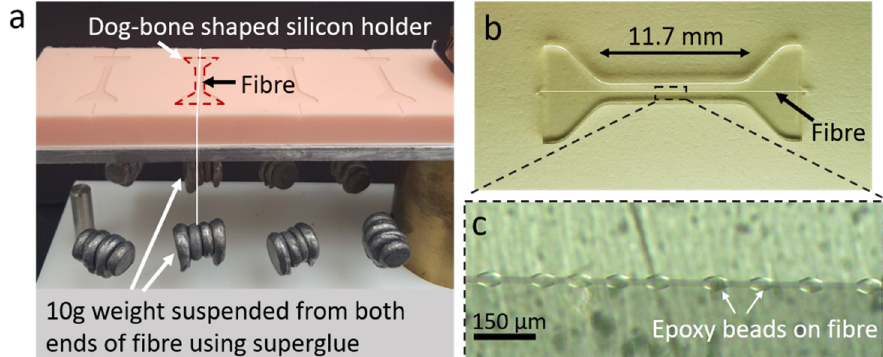
Figure 3. Single fibre fragmentation test–sample preparation. Fibre highlighted in white to show position. ( a ) Fibres are placed along the centre of a dog-bone shape mould and 10 g weights are suspended from both ends using super glue. Epoxy is then added and cured. ( b ) Dog-bone shaped sample after curing. Dimensions of the area tested are 11.7 × 1.0 × 2.0 mm. ( c ) Embedded beaded fibre in epoxy viewed under polarised light microscope, showing no observable voids.